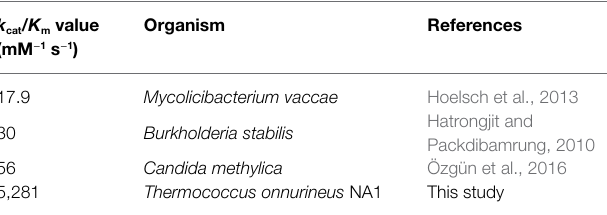
TABLE 3 | Comparison of catalytic efficiency ( k cat /K m ) values among NADP- dependent formate